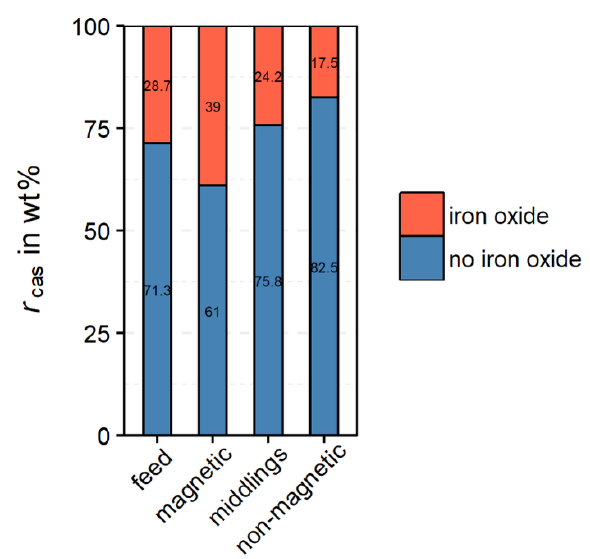
Figure 12. Distribution of cassiterite ( r cas ) in particles with iron oxides and without iron oxides.